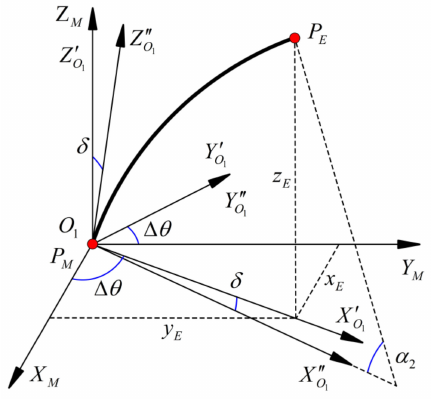
Figure 4. Second segment tubing coordinate